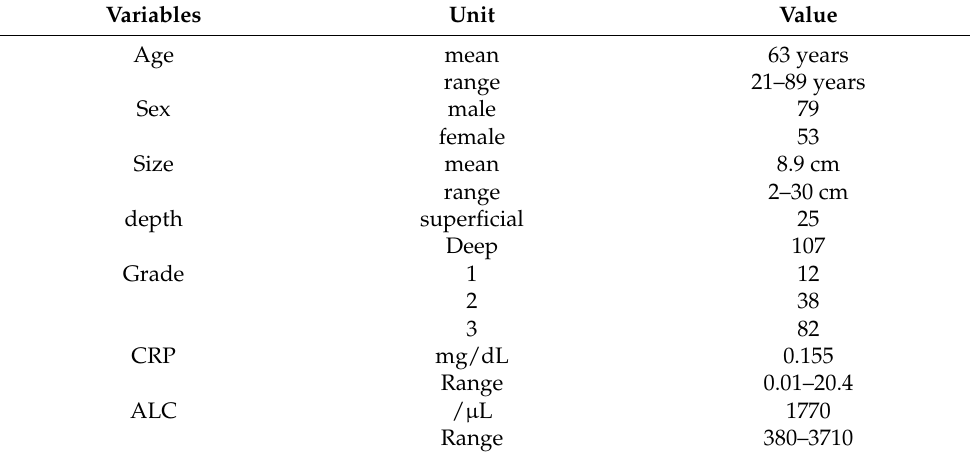
Table 1. Patient characteristics.